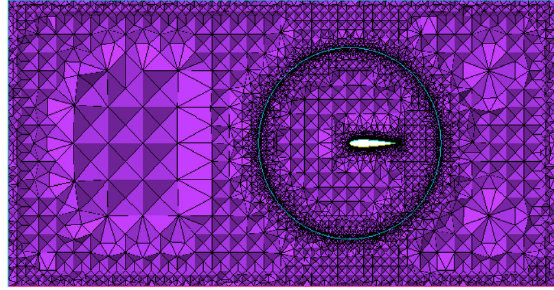
Figure 2. The cut plan of the mesh domain.